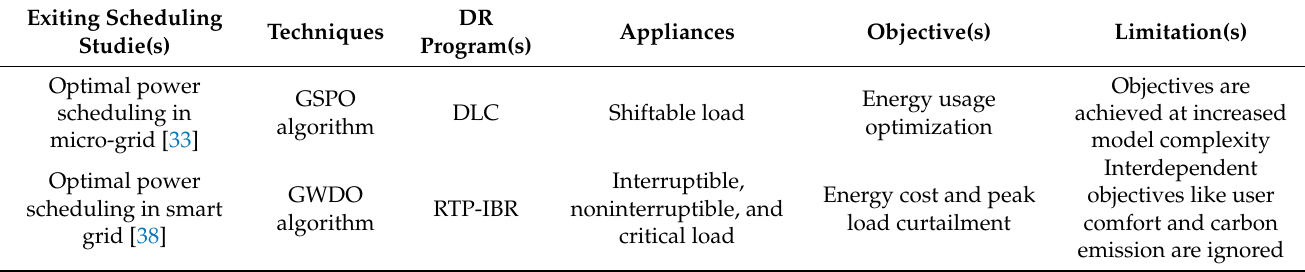
Table 1. Comparison of the proposed and exiting studies(s) in terms of techniques, appliances, DR programs, and